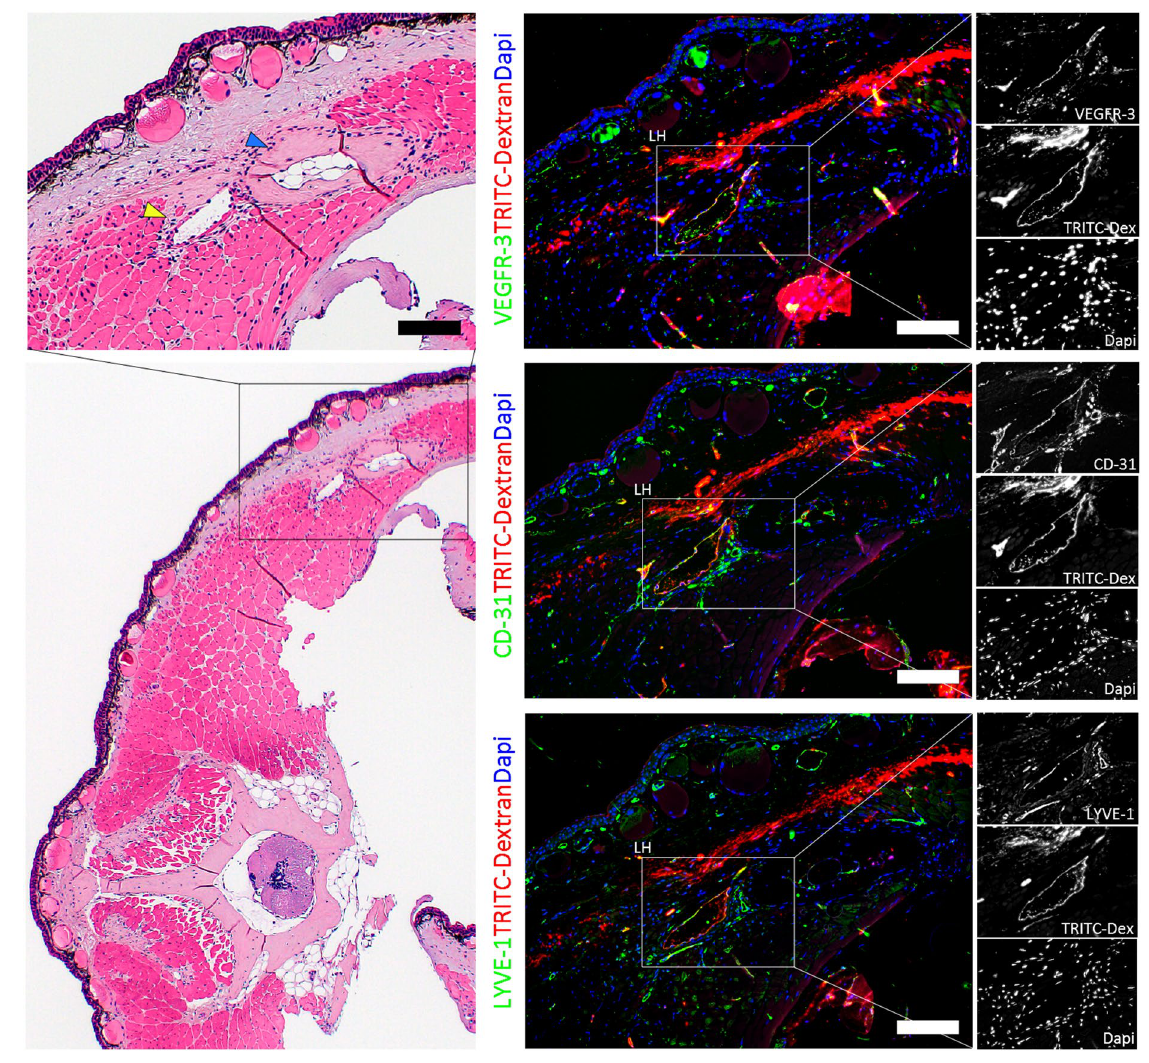
Figure 7. Lymphatic endothelial cell marker expression in newly regenerated lymphatics. Histological sections showing the regenerated lymphatic heart (LH) (yellow arrowhead) and the adjacent rib bone (blue arrowhead) in the abdominal region 120 days post complete microsurgical excision. The newly regenerated LHs had identical shape, size, structure, position, and function as the original LH. In addition, the newly regenerated LH demonstrated strong expression of lymphatic endothelial cell markers VEGFR-3 and LYVE-1 and pan-endothelial marker CD-31. The uptake of rhodamine-dextran dye confirmed the lymphatics were fully functional (Scale bars = 200